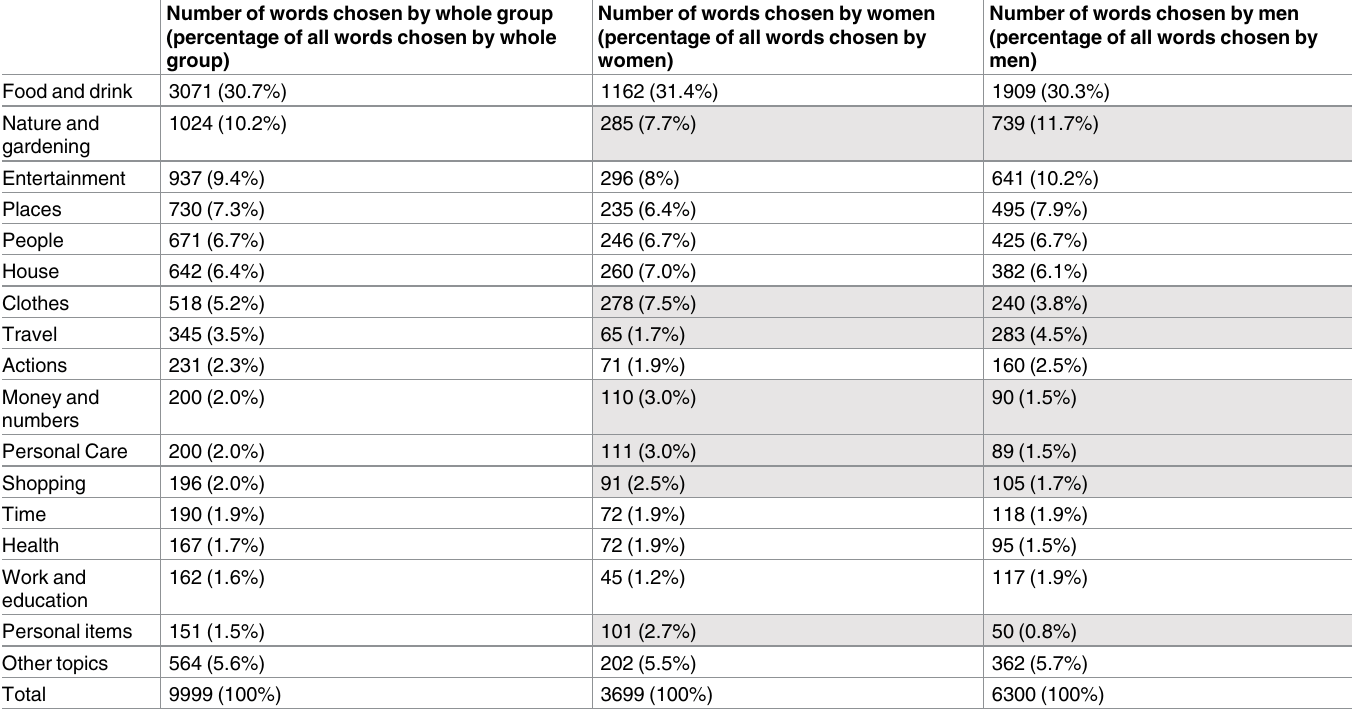
Table 3. The number of words chosen from each topic by gender. Number of words chosen by whole group (percentage of all words chosen by